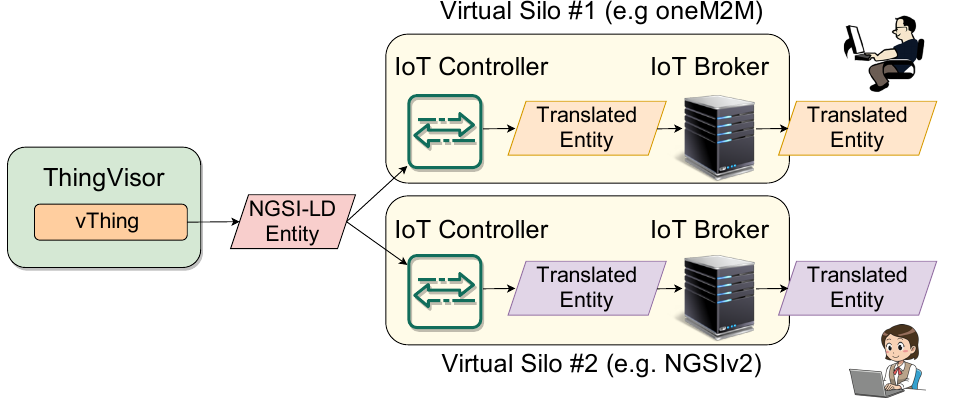
Figure 5. Interoperability. Table 3. Context data. from Table 1 translated to oneM2M. Listing 2. Context data. from Listing 1 translated to oneM2M.